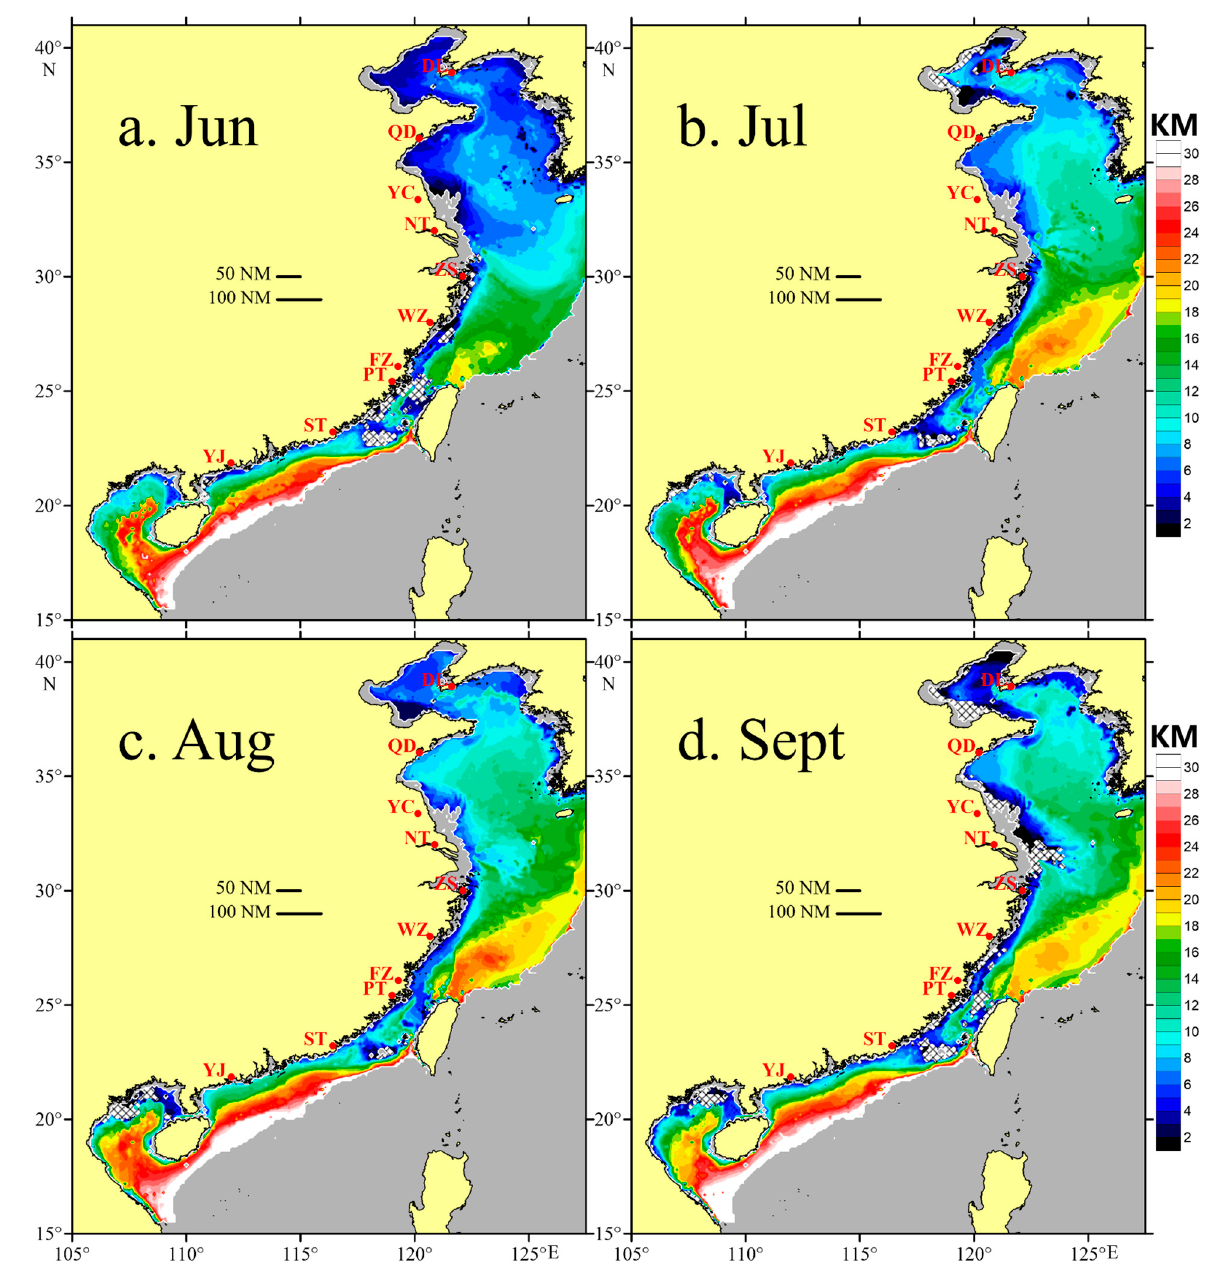
Figure 7. Distribution of the baroclinic Rossby radius (KM) in the waters adjacent to China. The two horizontal black bars indicate reference lengths of 50 NM and 100 NM, respectively. The crosshatching indicates the regions without stratification.